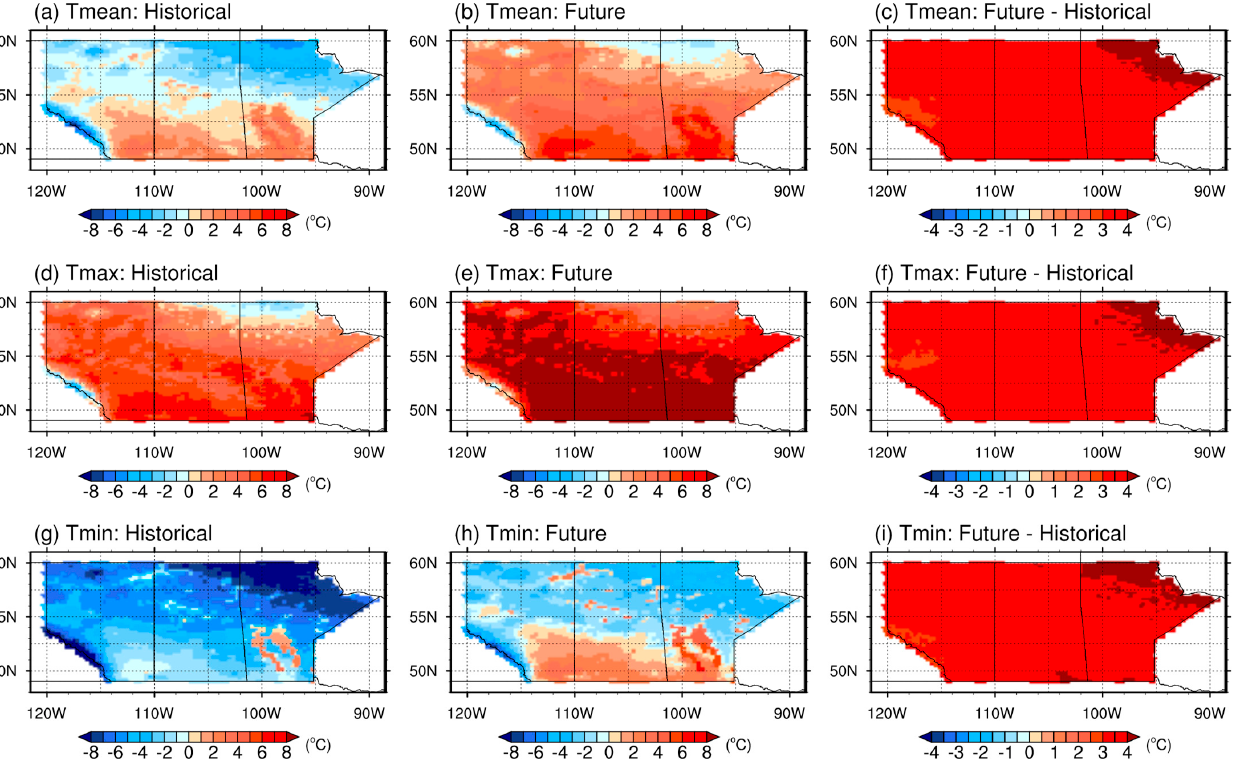
Figure 7. Projected variations of annual averages of T mean , T max , and T min for the period of 2066 to 2095 under RCP85. ( a , d , g ) show the historical distributions of T mean , T max , and T min , respectively; ( b , e , h ) show the future distributions of T mean , T max , and T min , respectively; ( c , f , i ) show the projected variations of V mean , V max , and V min , respectively.